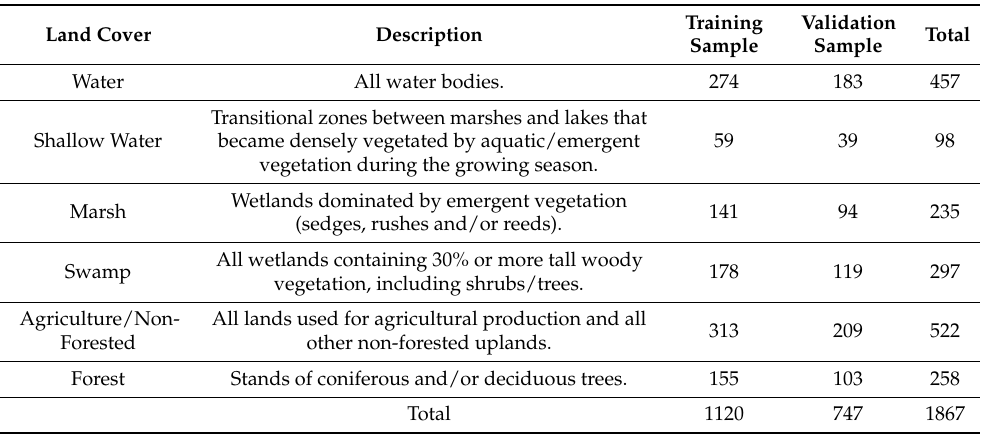
Table 5. Description of the land cover classes included in this research and number of training and validation